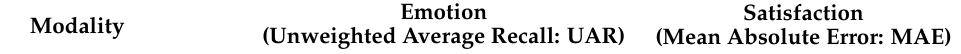
Table 1. Performance of uni- and multimodal tourist emotion and satisfaction estimation. The best performances are highlighted with bold text.